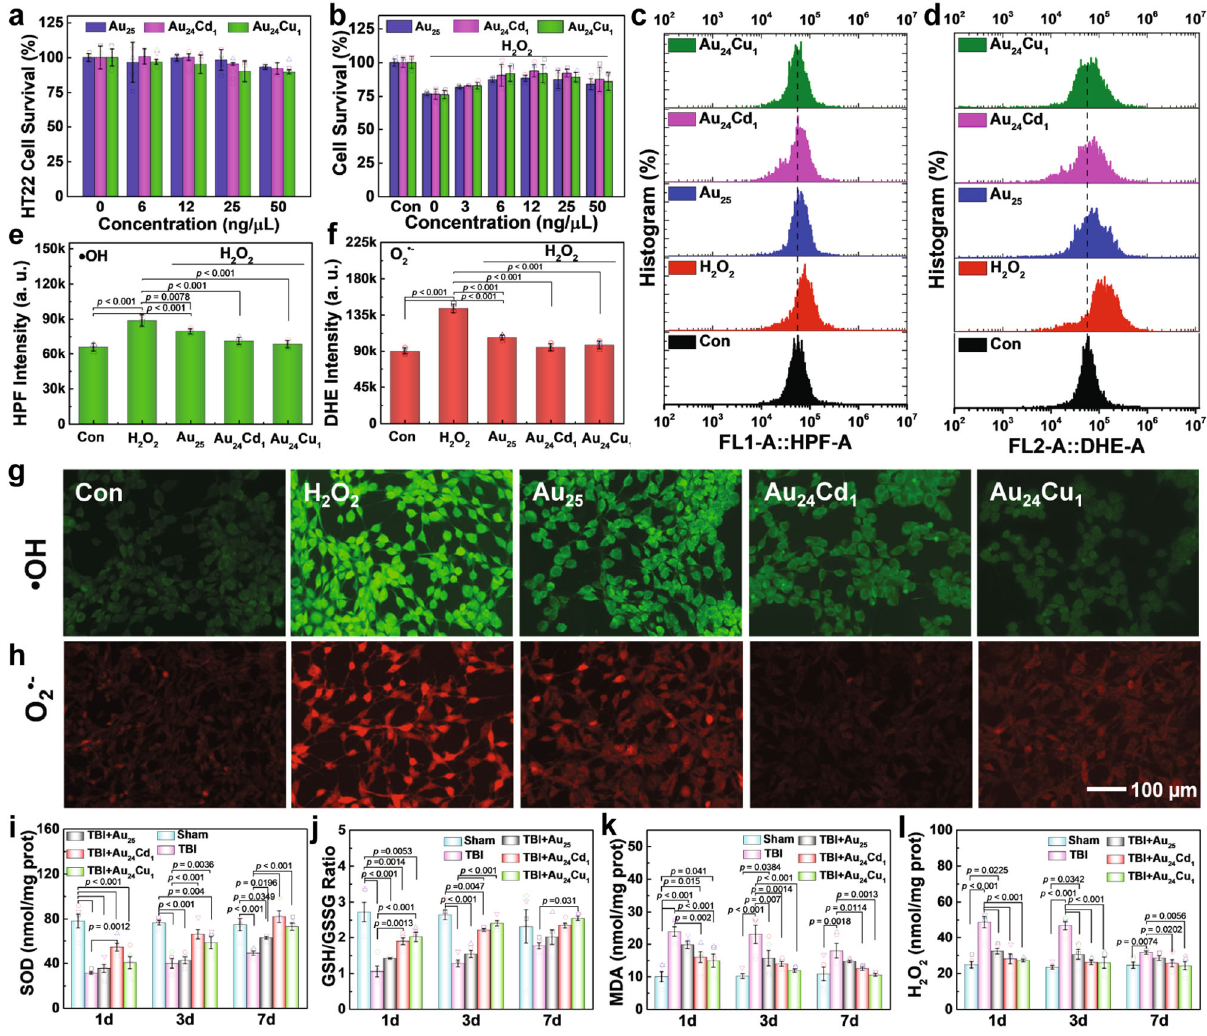
Fig. 5 Oxidative stress levels in vitro and in vivo before and after treatment of clusterzymes. a HT22 cell viability of clusterzymes ( n = 5 per group, data are presented as mean ± SD). b HT22 cell viability in the presence of H 2 O 2 with or without treatment of clusterzymes as determined by MTT assays ( n = 6 per group, data are presented as mean ± SD). Fluorescence quanti fi cation of cell staining for c , e (cid:129) OH and d , f O 2 (cid:129) − by fl ow cytometry ( n = 3 per group). Data are presented as mean ± SD and compared with the Con and H 2 O 2 groups, analyzed by one-way ANOVA with two-sided LSD test (adjusted p values are shown). Fluorescence microscopic images of intracellular g (cid:129) OH (green) and h O 2 (cid:129) – (red) levels induced by 100 μ M H 2 O 2 with or without clusterzymes treatment, stained by HPF and DHE probes, respectively. It can be seen that Au 24 Cu 1 has a better scavenging ability for (cid:129) OH and Au 24 Cd 1 shows better speci fi city for O 2 (cid:129) − , suggesting their individual selectivity for (cid:129) OH and O 2 (cid:129) − respectively. i – l Indicators for oxidative stress, including SOD, GSH/GSSG, MDA, and H 2 O 2 , of TBI mice with or without treatment of clusterzymes 1, 3, and 7 days post injury ( n = 5 per group). Data are presented as mean ± SEM and compared with the Sham and TBI groups, analyzed by one-way ANOVA with two-sided LSD test (adjusted p values are shown). Experiments were repeated independently g , h three times with similar